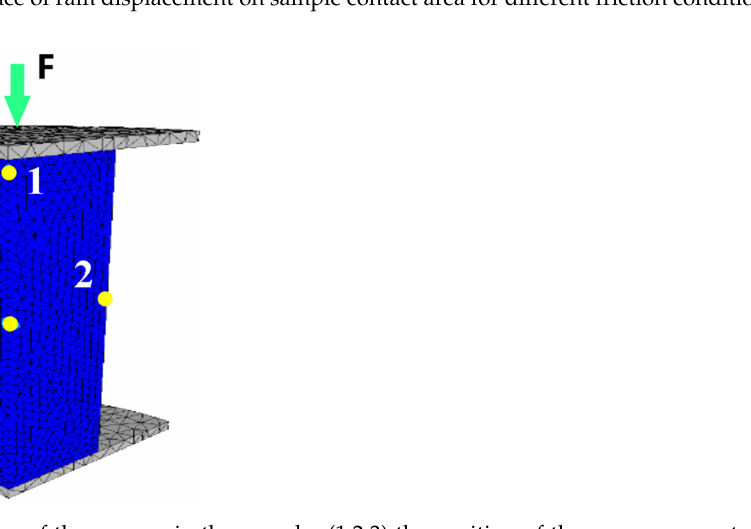
Figure 19. Position of the sensors in the sample: (1,2,3) the position of the sensors mounted in 3 different areas, ( F ) load force.